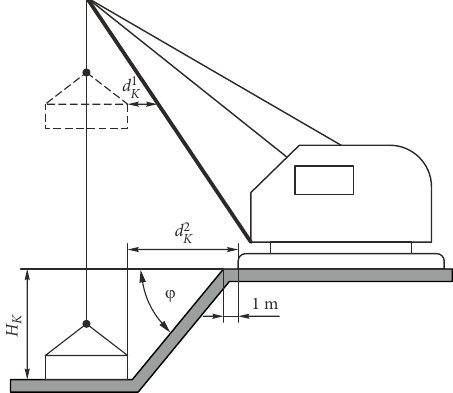
Figure 10. A schematic view of determining the parameters Figure 11. A schematic view of determining the parameters of automobile cranes